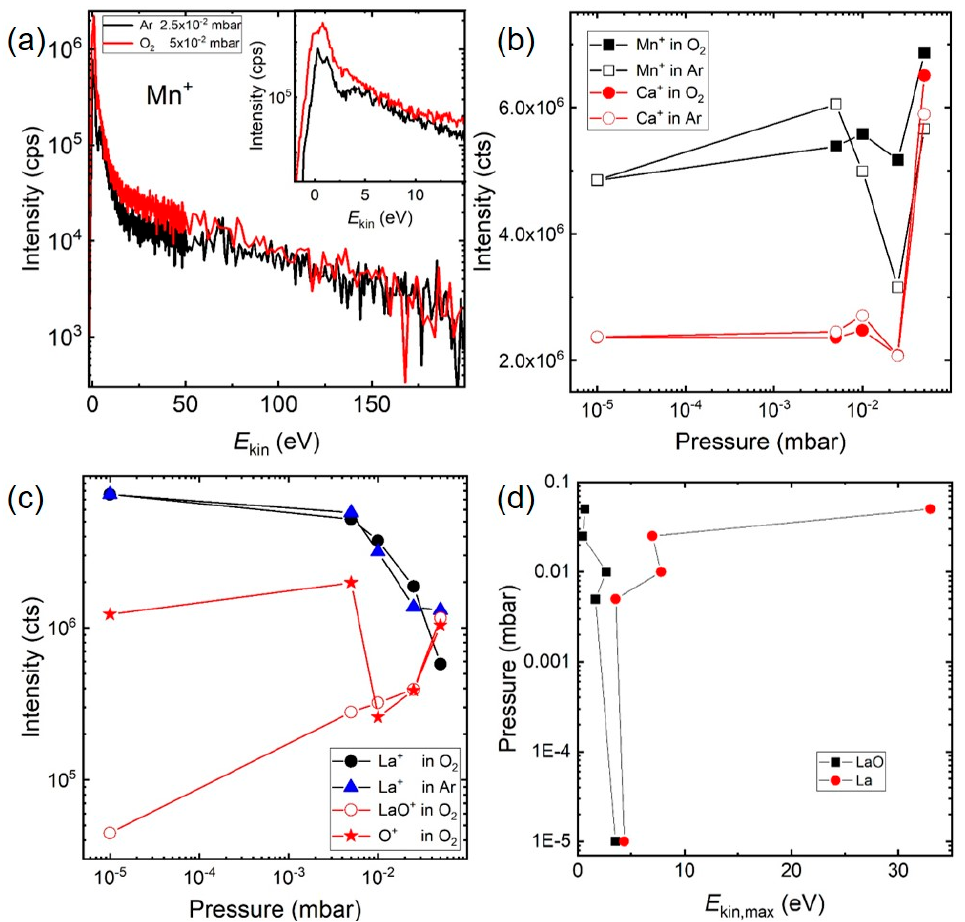
Figure 4. ( a ) Comparison of IEDs for Mn+ in 2 × 10 − 2 mbar Ar and 5 × 10 − 2 mbar O 2 . ( b ) Pressure dependence of Mn + and Ca + in O 2 and Ar. ( c ) Pressure dependence of La + , O + and LaO + in O 2 and Ar. ( d ) O 2 pressure vs. E kin,max of the ion energy distribution for La + and LaO + .